Question: Write a single sentence explaining what this figure depicts.
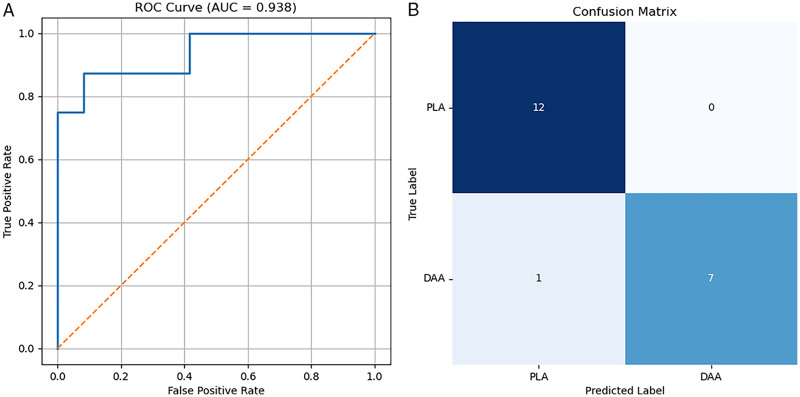
Answer: (A,B) ROC curve and model confusion matrix diagram.